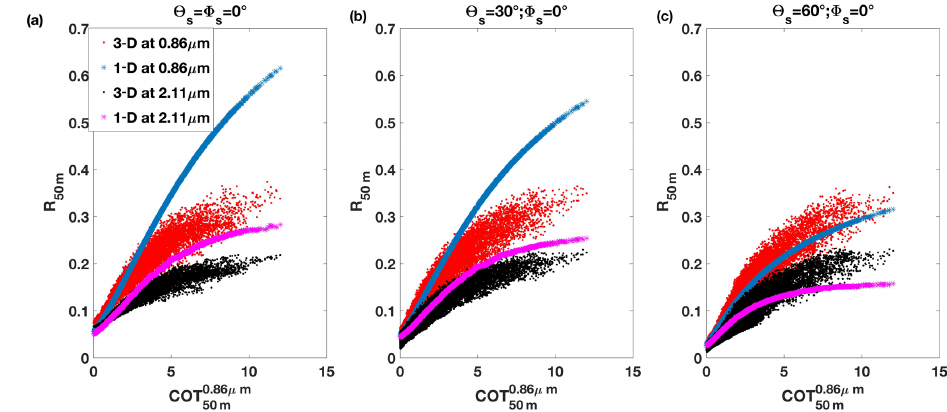
Figure 6. Reflectances ( R 50m ) for nadir view, as a function of 50m optical thickness for channels centered at 0 . 86µm (in red and blue colors for 3-D and 1-D computations, respectively) and 2 . 13µm (in black and magenta colors for 3-D and 1-D computations, respectively) plotted separately for the three solar zenith angles (cid:50) s .